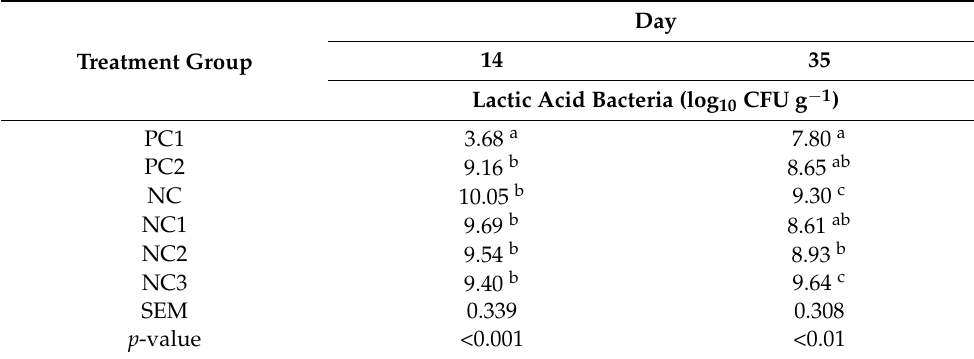
Figure 2. The effect of the plant materials on the bacterial load of E. coli in the caecum from 7 to 35 days of age. Means without common superscripts ( ab ) indicate the significant differences (*, p < 0.05) between the treatments. PC1 = positive control 1 (NC + 40mg/kg amoxicillin); PC2 = positive control 2 (recommended nutrient specification); NC = negative control (reduced nutrient specification); NC1 = NC + herb of A. pilosa Ledeb; NC2 = NC + herb of A. chinensis Bunge; and NC3 = NC + tuber of S. glabra Roxb. Table 7. The effects of the treatment groups on the caecum lactic acid bacteria bacterial load at 14 and 35 days of